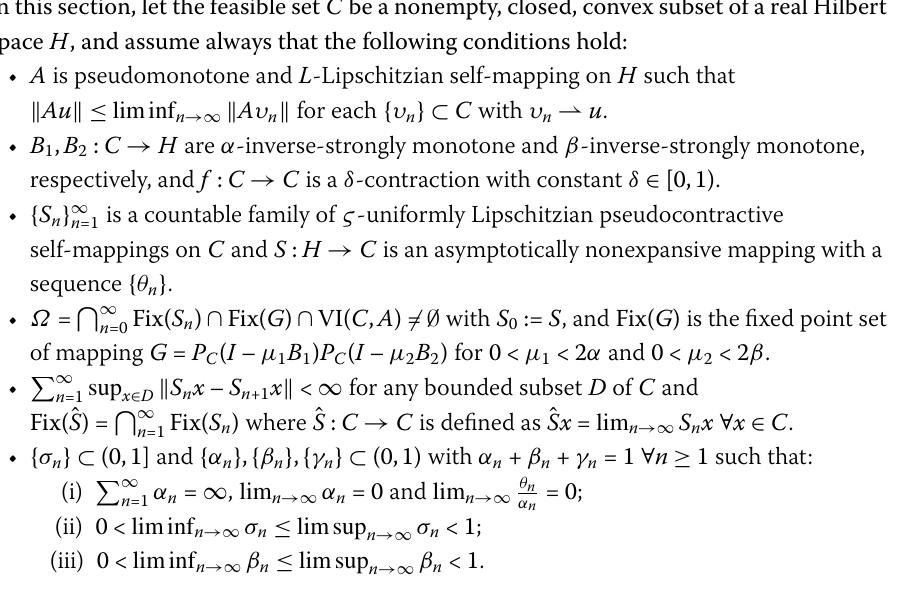
Algorithm 3.1 Initialization : Given γ > 0, μ ∈ (0,1), (cid:4) ∈ (0,1), pick an initial x 1 ∈ C arbi-